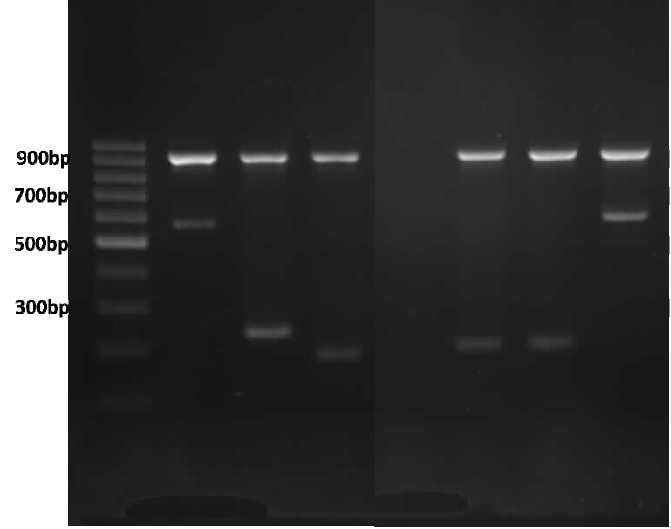
Figure 2. Multiplex ARMS PCR genotype analysis of α globin gene cluster on agarose gel electrophoresis. Lane 1 ladder; Lanes 2–4 are positive controls for Cd 59 (G > A), Cd 125 (T > C), and term Cd TAA > CAA (Hb CS) with their respective bands; Lane 5 non-template control; Lanes 6 and 7 Hb CS; and Lane 8 Cd 59 (G > A); 930 bp bands on Lanes 2–4 and 6–8 are internal control bands amplifying a segment of 3' UTR of LIS1 gene.